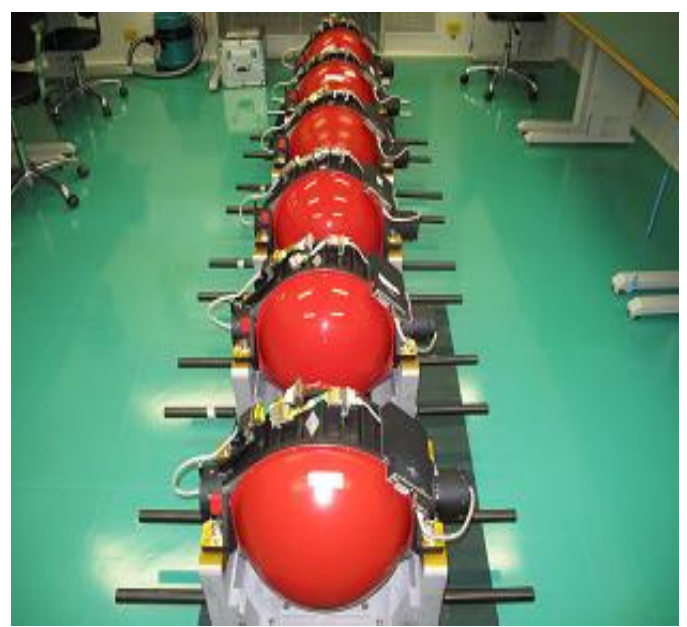
Figure 5. Control moment gyroscopes.